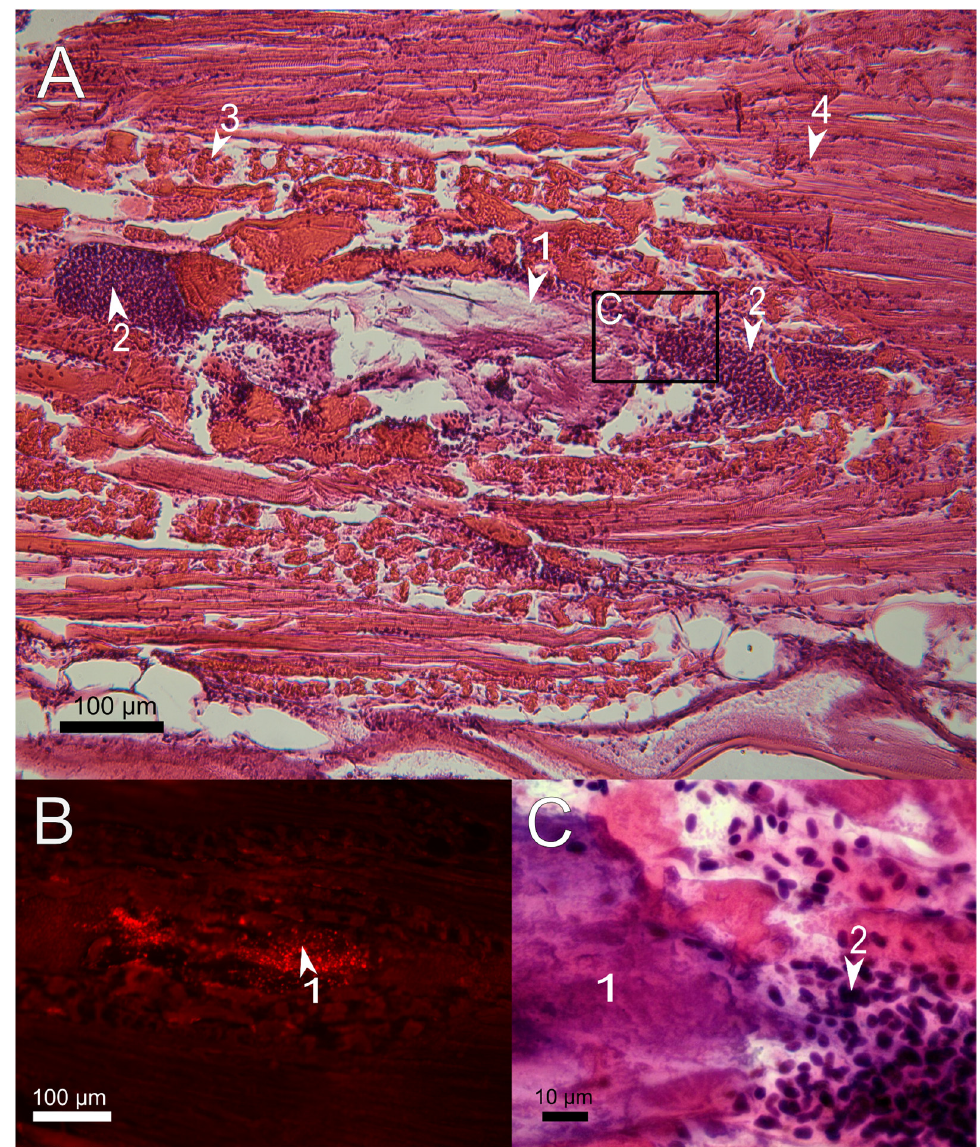
Figure 3. Sagittal histological section of D. rerio muscles 24 h after the injection of 2.7% PAAH + PMs. ( A ) histological section of the injection site (×10), H&E stain; ( B ) fluorescence of the unstained histological section in the red channel indicates microcapsules loaded with SNARF-1; ( C ) enlarged image of region from A depict the border between the hydrogel and the spilled erythrocytes (×100); 1, PAAH + PMs; 2, hematoma consisting of spilled erythrocytes; 3, damaged myofibrils; 4, normal myofibrils.